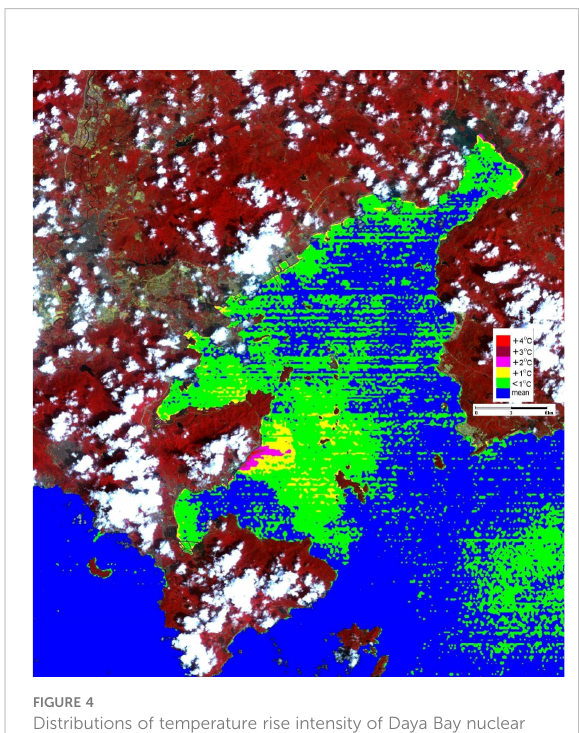
FIGURE 4 Distributions of temperature rise intensity of Daya Bay nuclear power cooling water discharge on September 21, 2008 (TM data) derived from satellite observations.